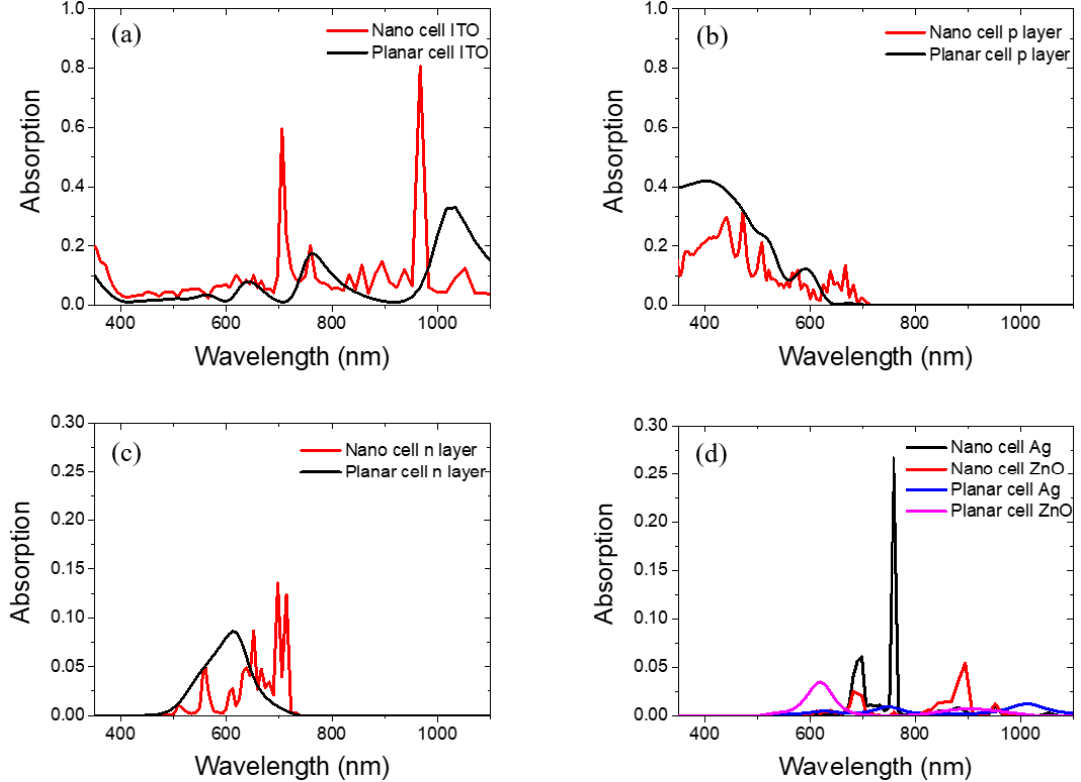
Figure 10. ( a ) Indium tin oxide (ITO) absorption; ( b ) p layer absorption; ( c ) n layer absorption; ( d ) Ag/ZnO BR absorption.